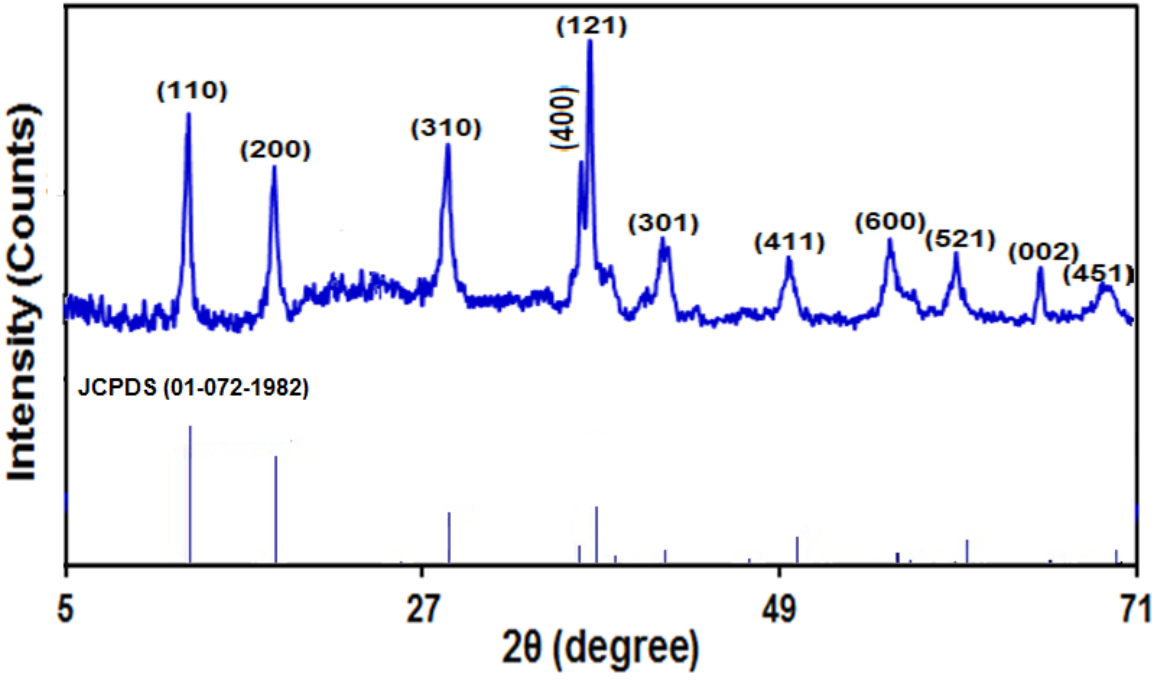
Figure 4. XRD spectrum captured for as-fabricated manganese dioxide nanorods.